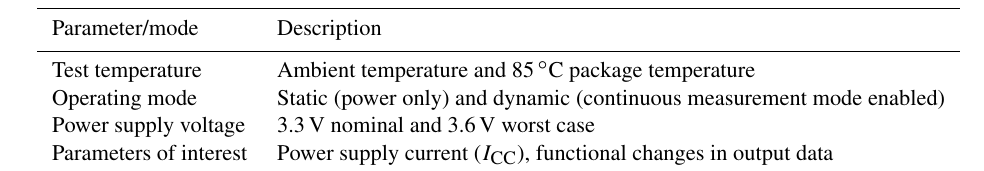
Figure 2. (a) The PNI RM3100 mounted within the beam line for SEE testing. (b) Close-up of the decapsulated PNI ASIC with a polyimide heating strip attached to the back of the PNI RM3100. Table 2. Test Conditions.